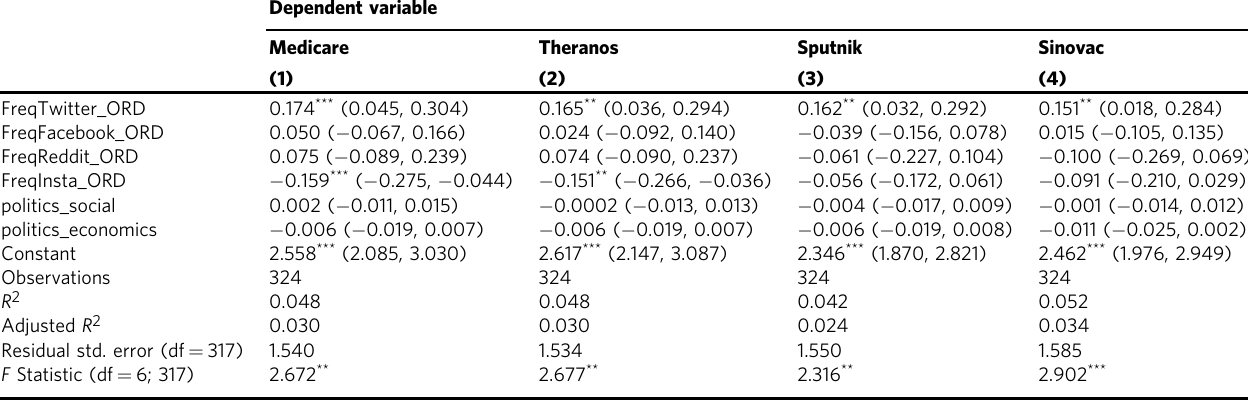
Table 4 Regressions for willingness to take unavailable (fake) vaccines, Sputnik, and